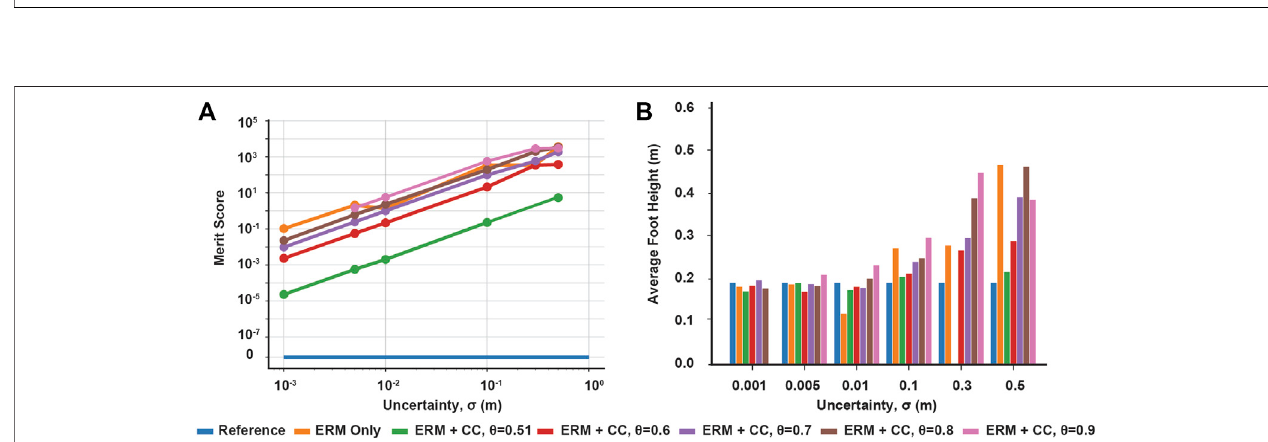
FIGURE 7 | Chance constraint mediated trade-off between contact distance feasibility and average foot height for robustness. (A) Merit scores across distance uncertainty and risk bounds, quantifying the violation of the expected contact distance constraint. (B) Average foot height across uncertainty and risk bounds, where higher average height indicates more contact-robust hopping. Both constraint violation and maximum foot height increase with increasing uncertainty and with increasing risk bounds. Missing data points indicate the optimization was not solved successfully.